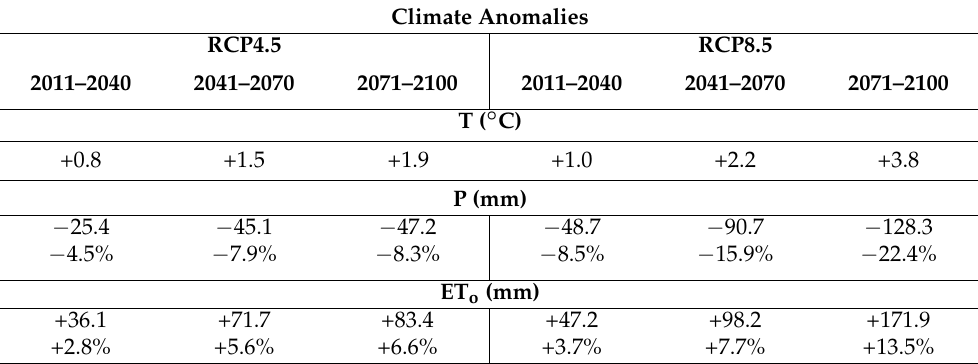
Table 4. Annual average anomalies of air temperature (T), precipitation (P), and reference evapotran- spiration (ETo) for the climate change scenarios compared to the reference period